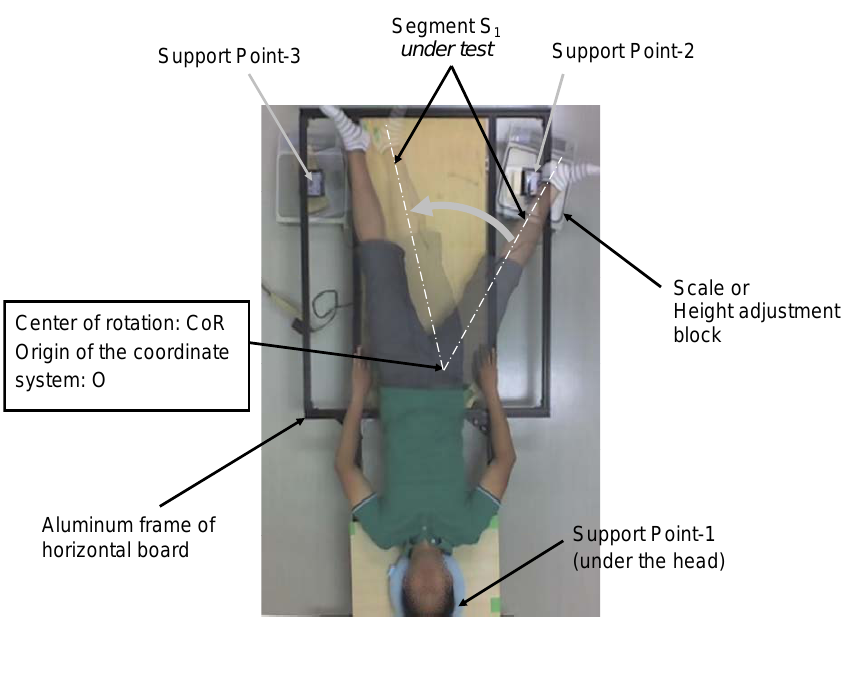
Figure 5. Overlapped pictures used in the analysis.